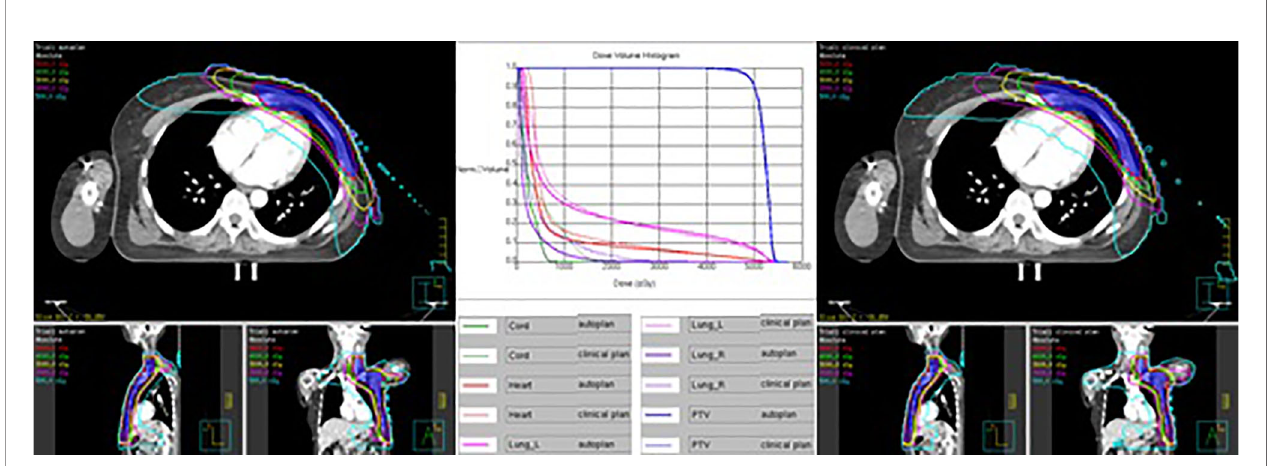
FIGURE 1 | Dose distribution and DVH for autoplan (left) and clinical plan (right) of 1 left-sided PMRT case. The blue colorwash area is PTV. The medium solid lines are isodose